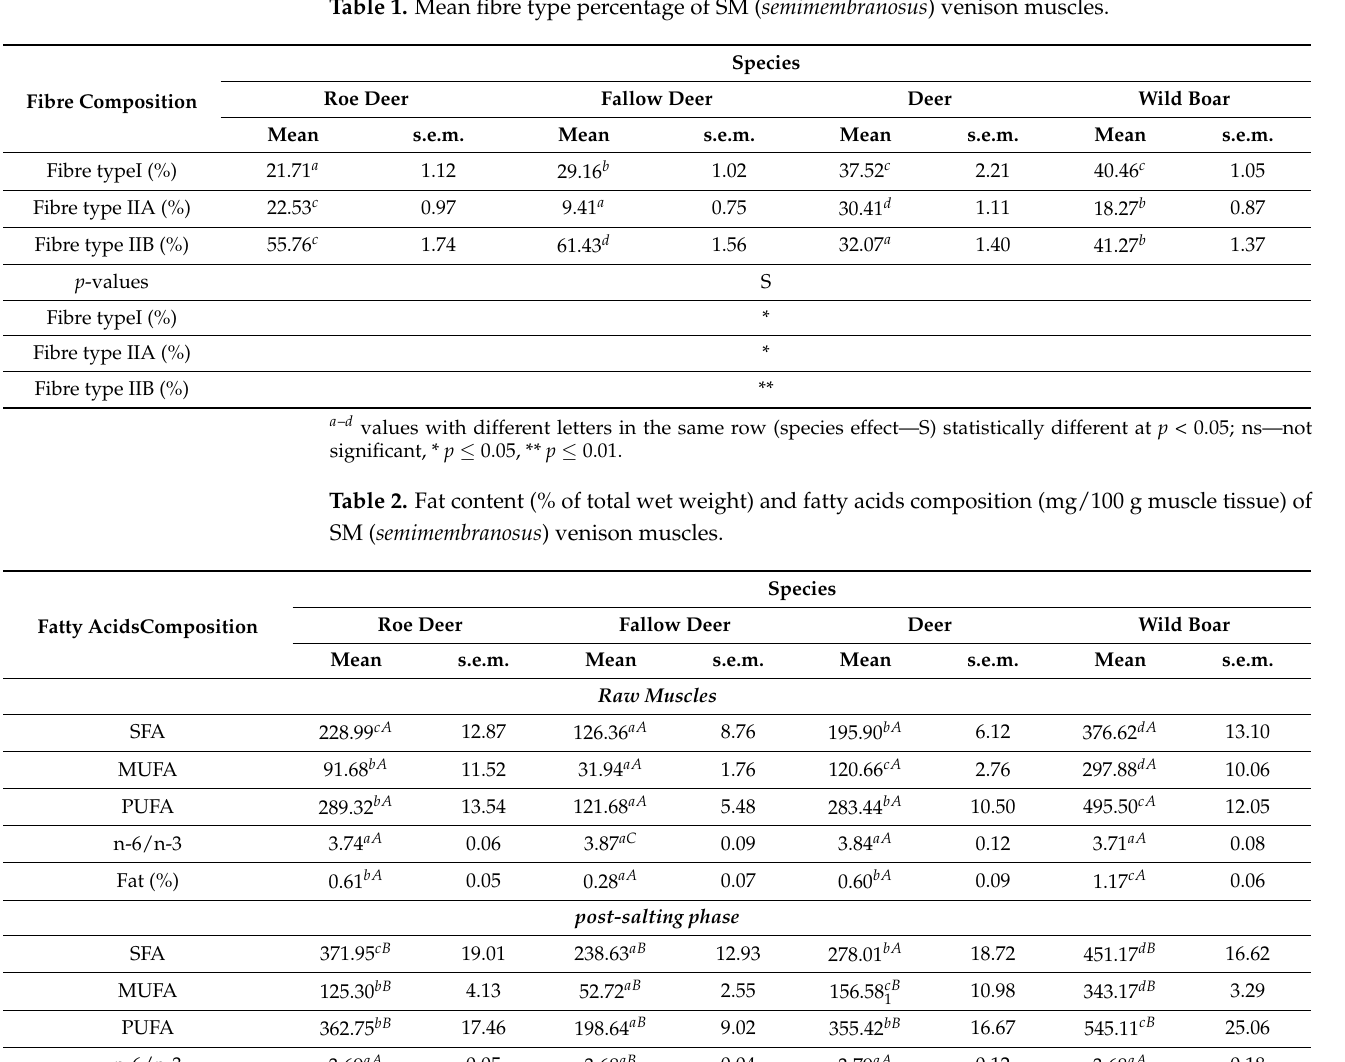
Table 1. Mean fibre type percentage of SM ( semimembranosus ) venison muscles.